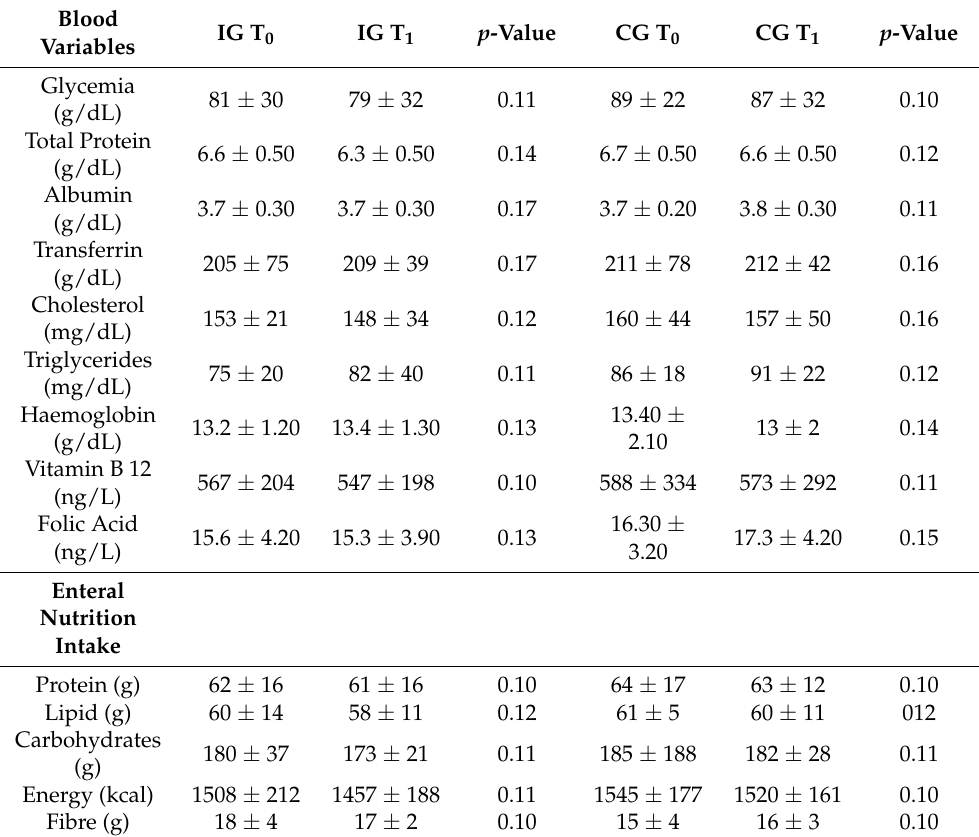
Table 1. Clinical and nutritional feature comparison between T 0 and T 1 for both IG and CG groups, computed by Mann–Whitney test. Each parameter is reported as average ± standard